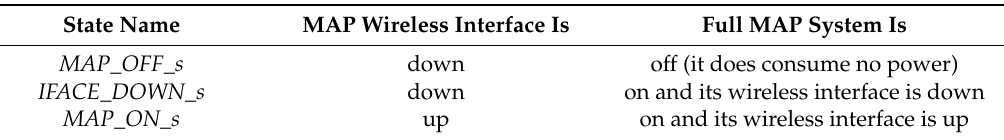
Table 1. Different MAP states from the power consumption point of view.